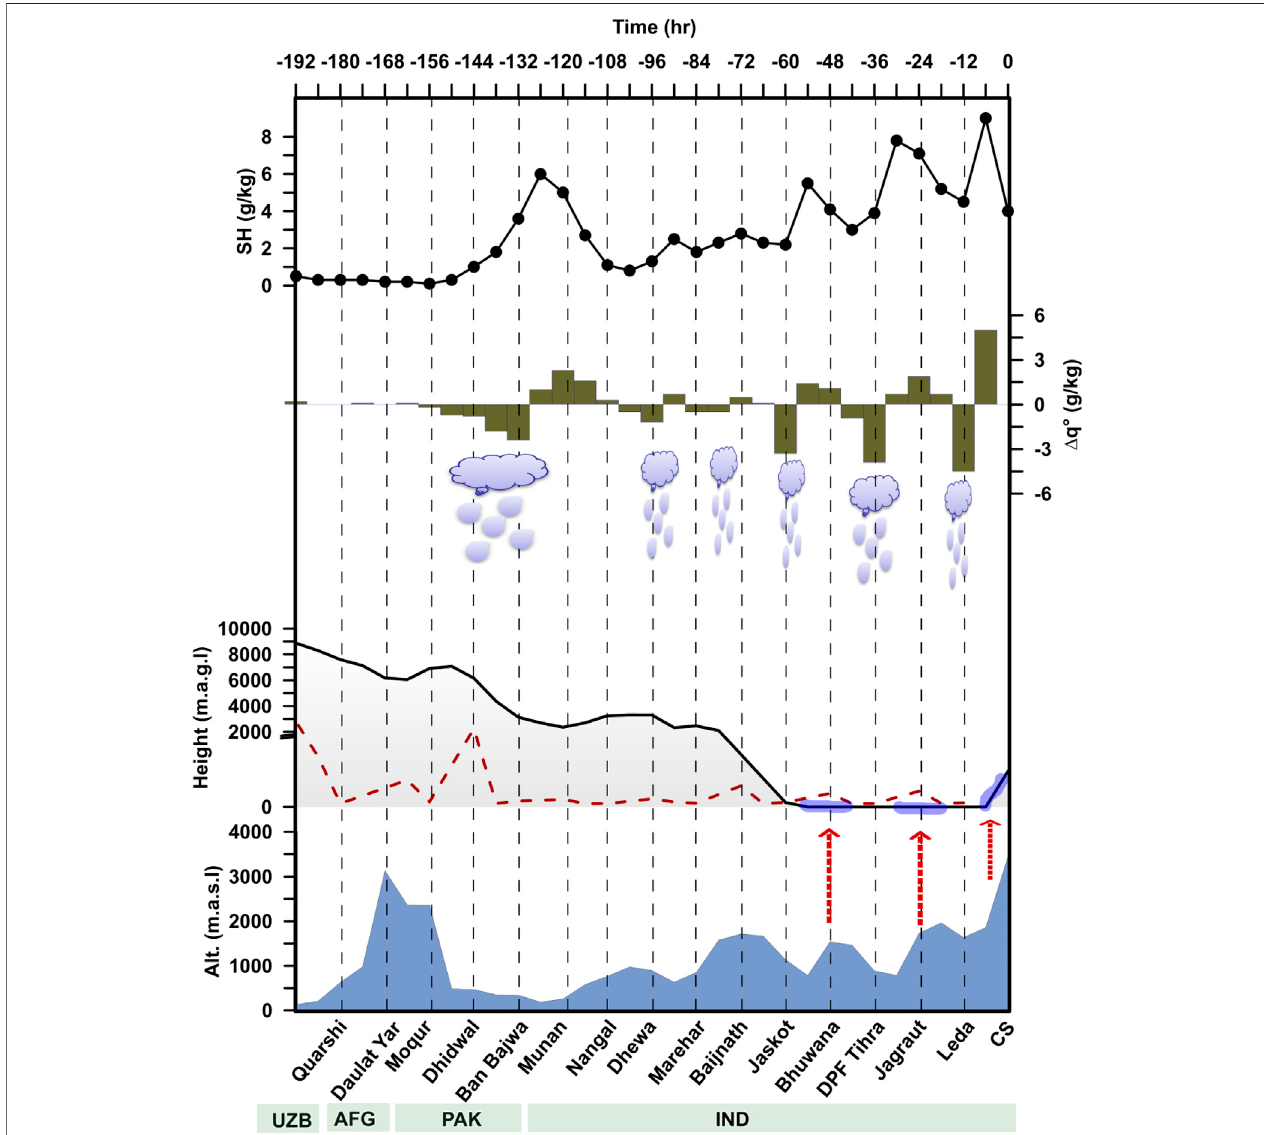
FIGURE6| LagrangianmoisturediagnosticssketchusingthemethodofSodemannetal.(2008)foridentifyingthemoistureuptakesalongthebackwardtrajectory path from CS (Chhota Shigri), India to Quarshi (Uzbekistan) (black line). A in total 192 h backward (time in hours at top) model run was performed where SH (back fi lled circle)representsthespeci fi chumidity(g/kg)while Δ q ⁰ (barchartingray color)representsthedifferenceinSHofanairparcelat 6 hintervals. BLH,boundarylayerheight (dashed red line) is obtained from the HYSPLIT model. Similar as done by Sodemann (Sodemann et al. (2008)), moisture uptake points (thick blue line on air parcel trajectory) were considered only, if the air parcel trajectory height is lower than the BLH with Δ q ⁰ is equal to 0.02 g/kg, while moisture increase (positive Δ q ⁰ ) over the trajectory are the point of moisture decrease.